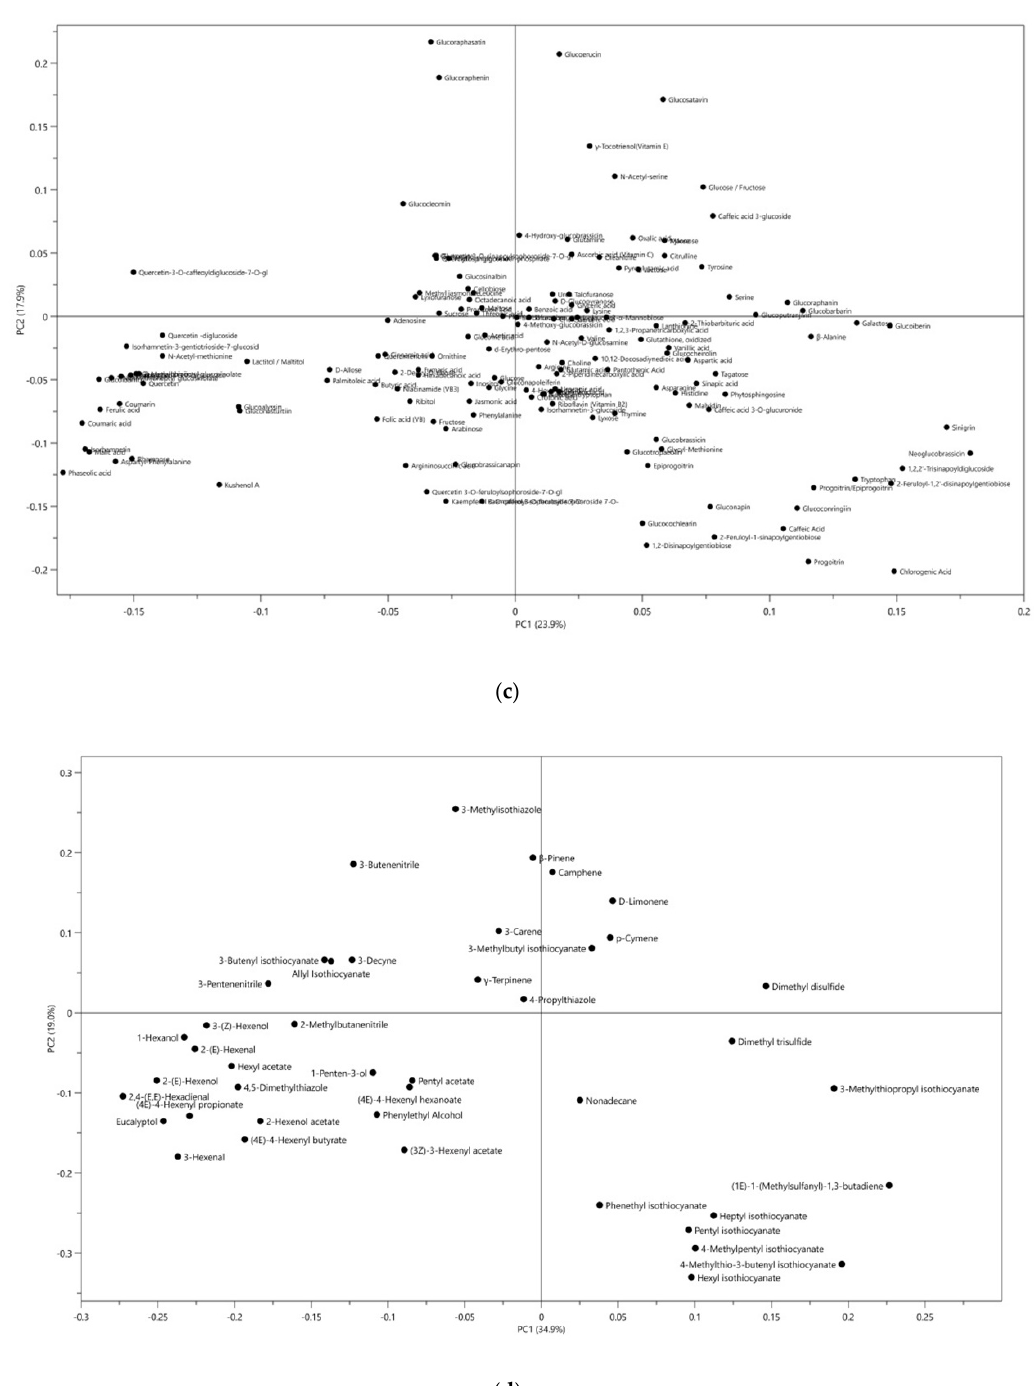
Figure 2. Principal component analysis (PCA) showing separation of 12 vegetables for data from two different experiments and two different datasets. ( a ) Score plot of PCA analysis based on non-volatile compounds, • Cherry Radish, • Radish, • Rocket Salad, • Watercress, • Chinese Cabbage, • Cabbage, based on volatile compounds; ( c ) loading plot of PCA analysis based on non-volatile compounds; ( d ) loading plot of PCA analysis based on volatile compounds. The specific names of metabolites are listed in Supplementary Materials Figure S1.